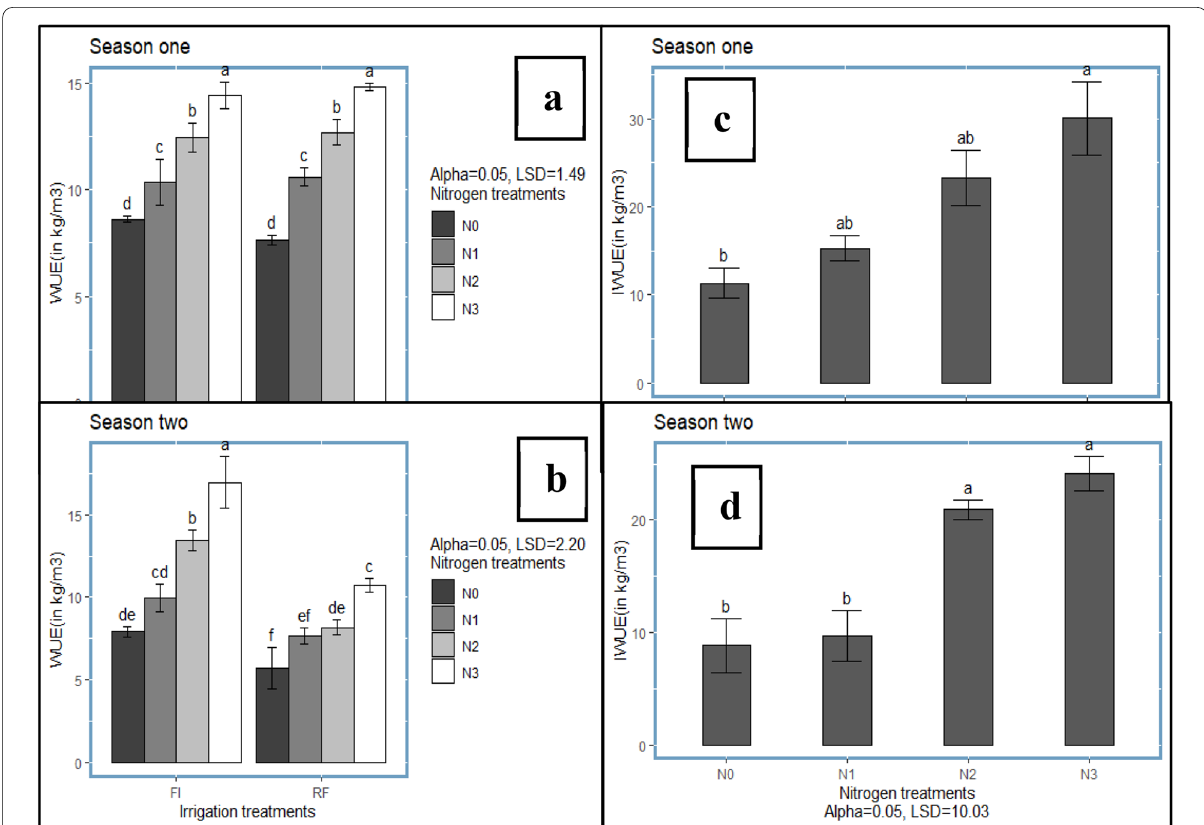
Fig. 4 Means separation of WUE and IWUE of different growing seasons. Different letters indicated significant difference